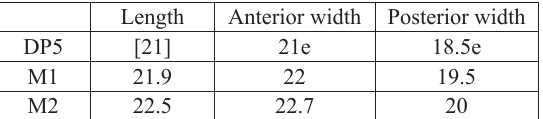
Table 2. Linear dimensions (in mm) of cheek teeth of Italosiren bel- lunensis (MGPD-20/21Z). Measurements in brackets, preserved crown length; e, estimated